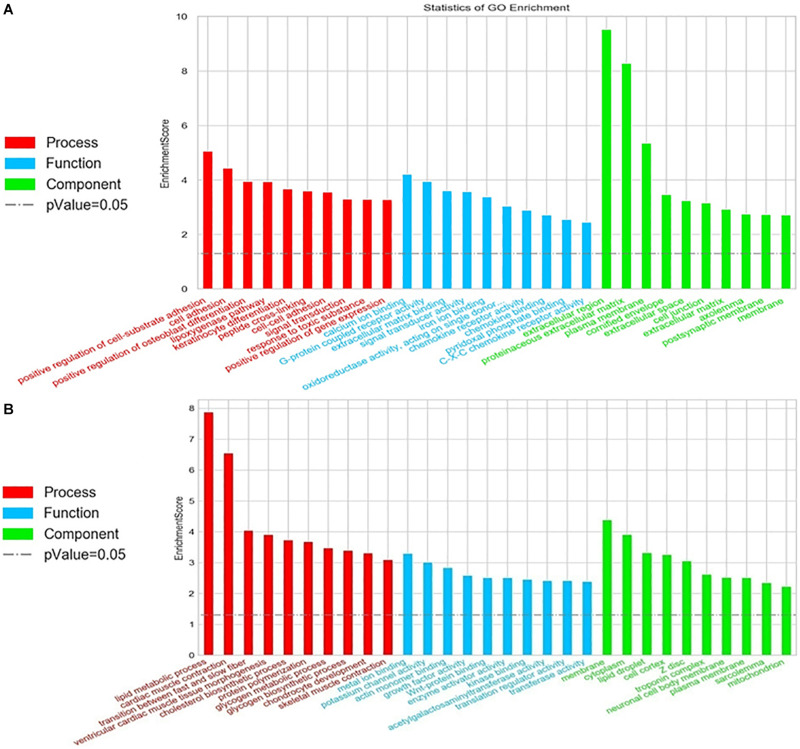
Gene Ontology (GO) analysis of the differentially expressed mRNAs. Go annotation of differentially expressed mRNAs with top 10 enrichment scores covering domains of biological processes, cellular components, and molecular functions. (A) Upregulated and (B) downregulated mRNAs. The GO terms with corrected P < 0.05 were considered significantly enriched by differentially expressed genes.